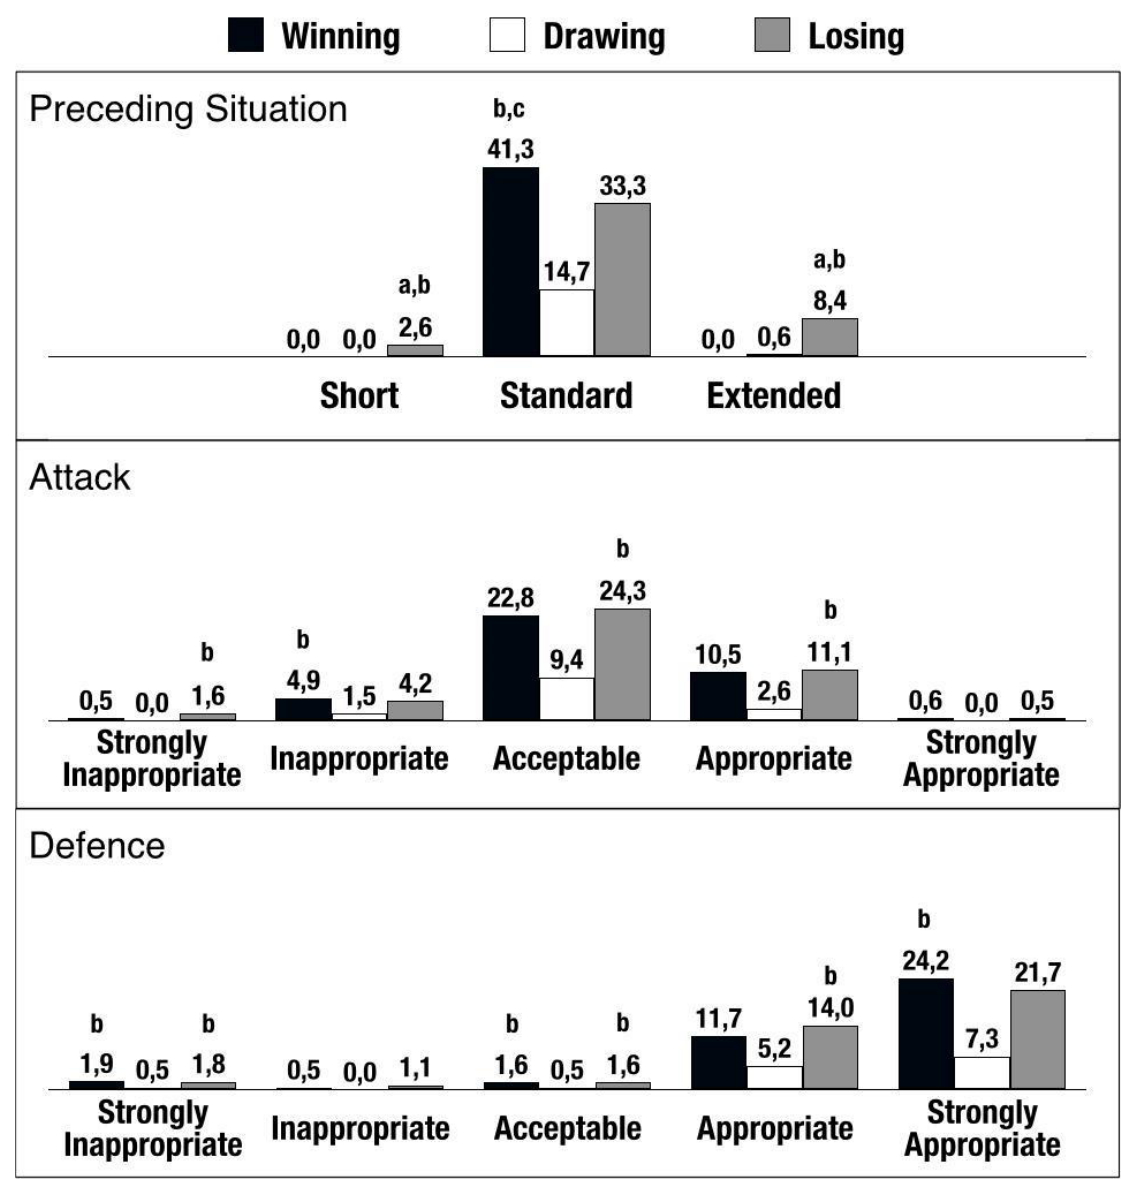
Figure 4. Median percentage of relative quality in match status comparisons. Note: Match status statistics were conducted considering the matches as unit of analysis. In this case, both teams alternated among winning, drawing and losing during the same match (i.e., differently from strong vs. weak teams and winner vs. loser teams). Significant differences: a = p < .05 vs. winning; b = p < .05 vs. drawing; c = p < .05 vs.